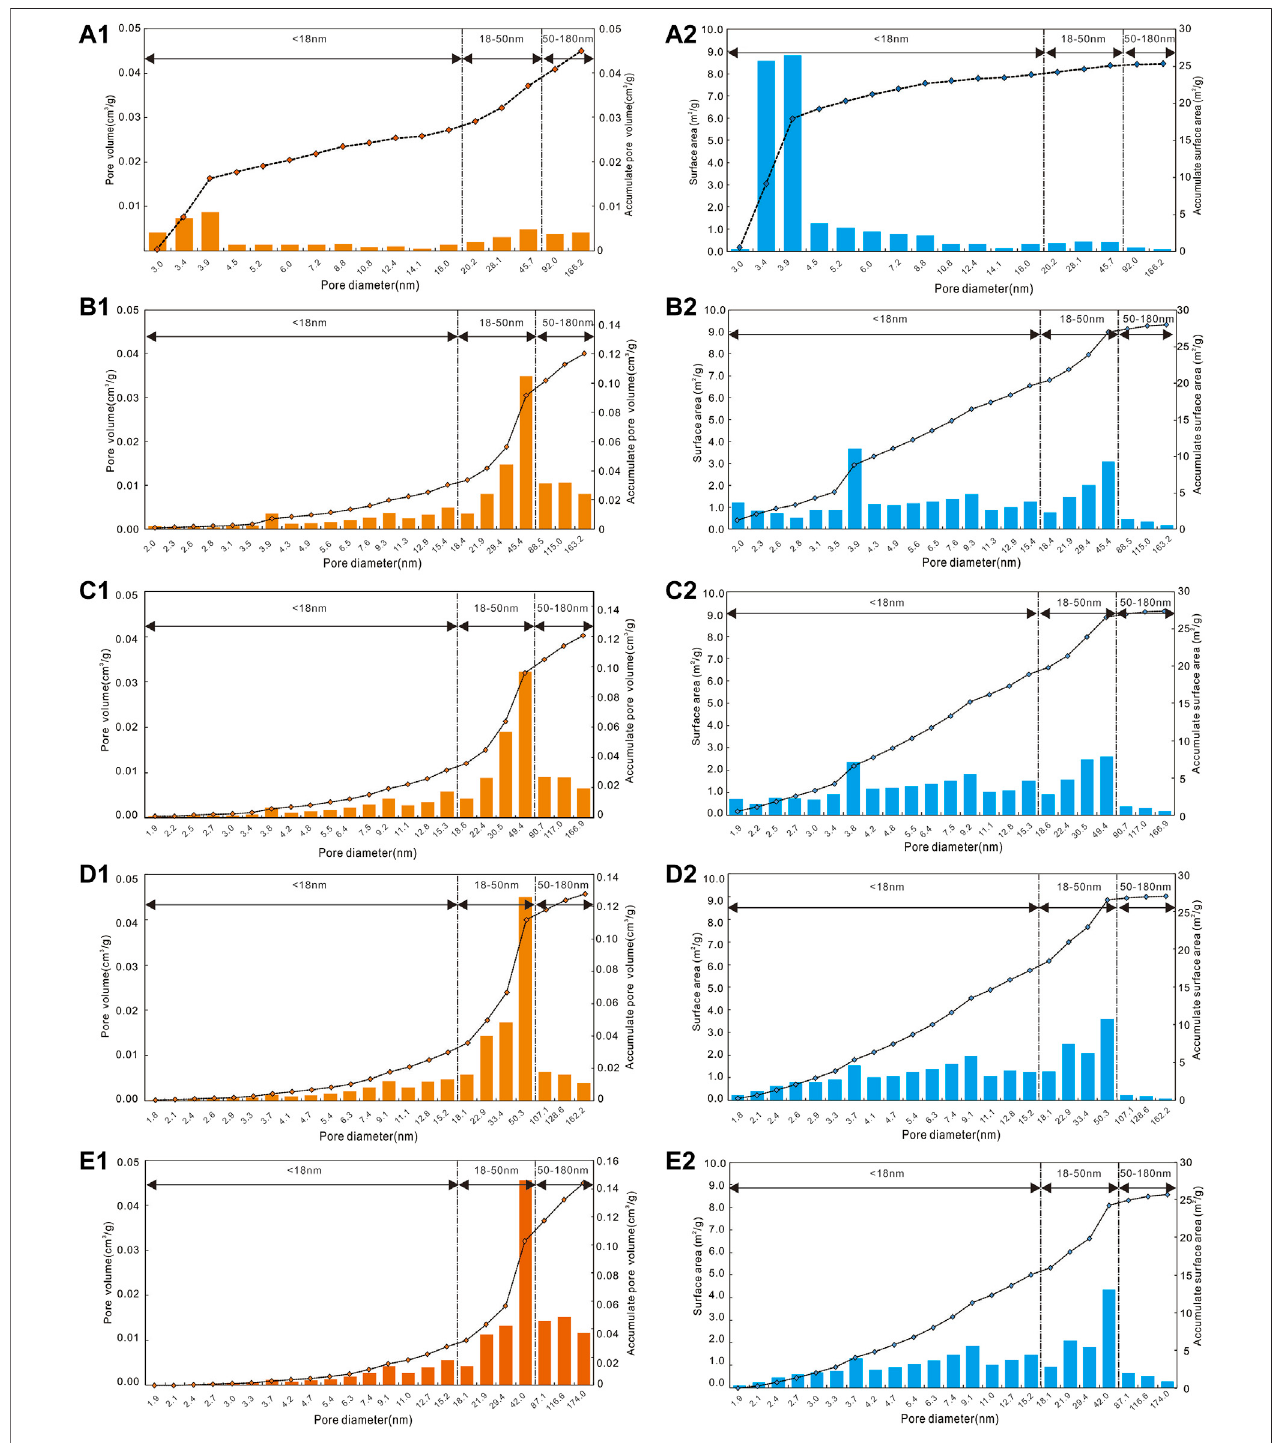
FIGURE 8 | BJH pore volume and BET surface area distribution at different temperatures. (A) -original sample, (B) -250 ° C, (C) -350 ° C, (D) -450 ° C, (E) -550 ° C.